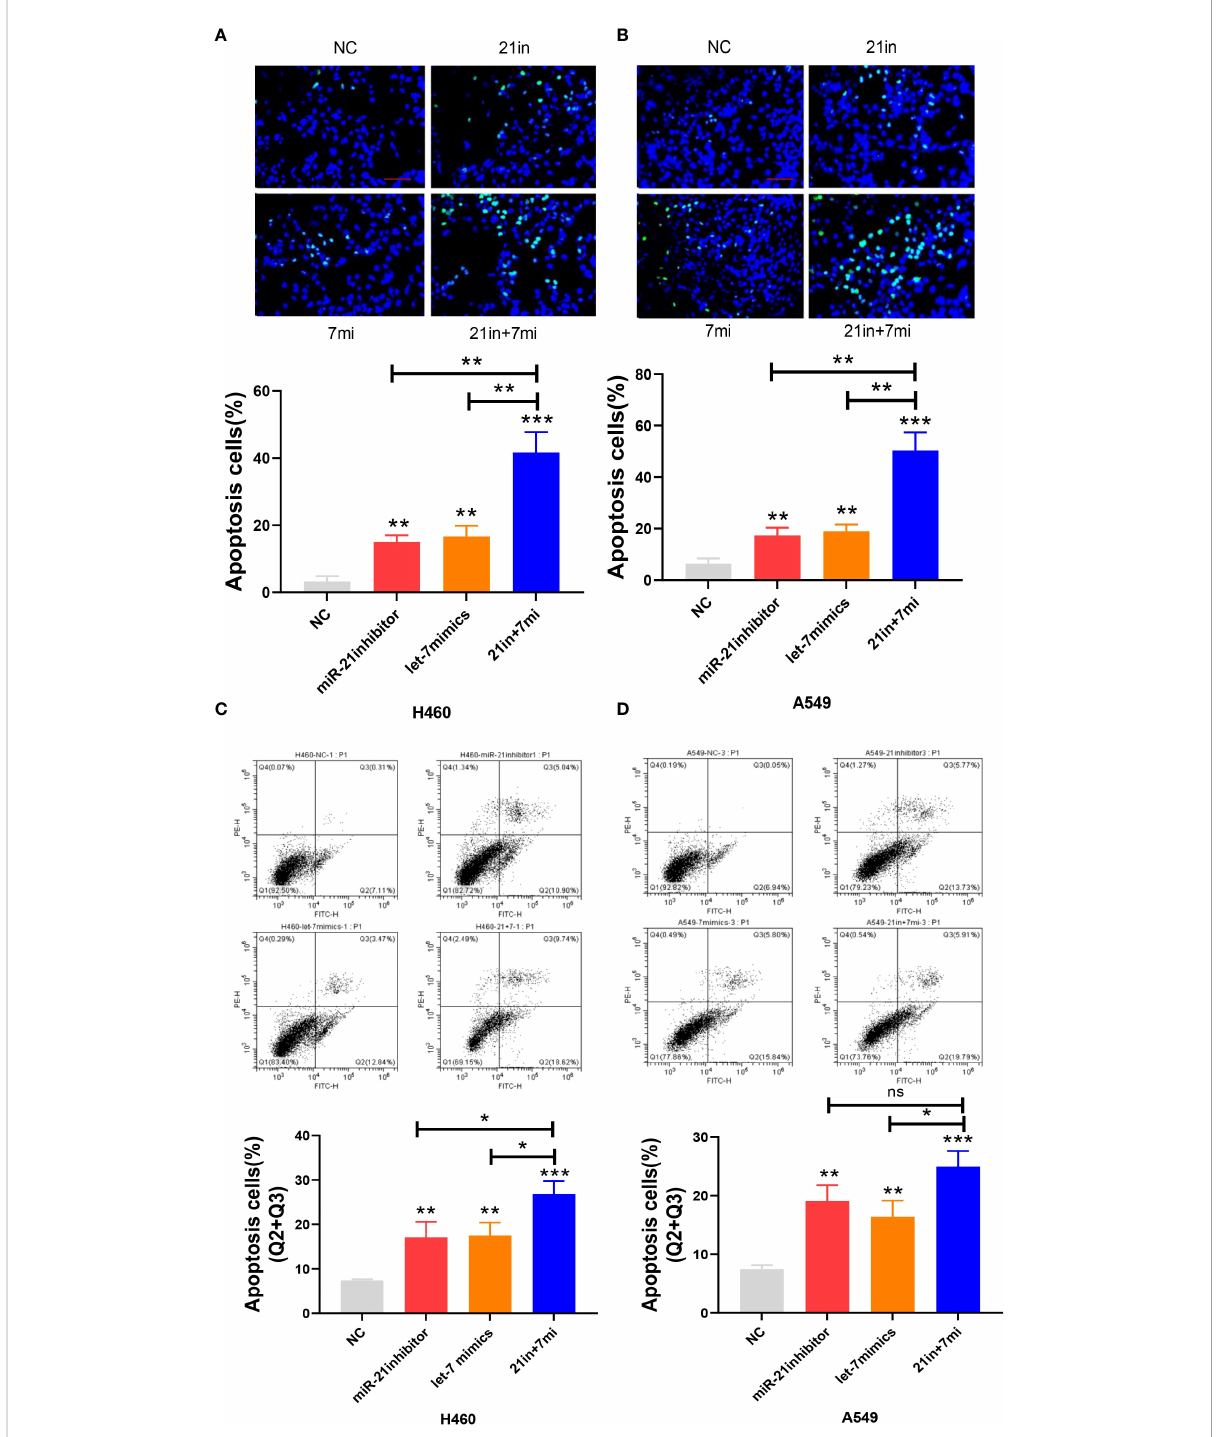
FIGURE 3 Apoptosis assay of lung cancer cell lines. (A, B) The apoptosis of cells as assessed by the TUNEL assay after transfection of miR-21/let-7 inhibitors or mimics in lung cancer cell lines. (C, D) Results of the fl ow cytometry assay after transfection with miR-21/let-7 inhibitors or mimics in lung cancer cell lines (scale bar: 100 m m; ns, no signi fi cance; * p < 0.05; ** p < 0.01; *** p <